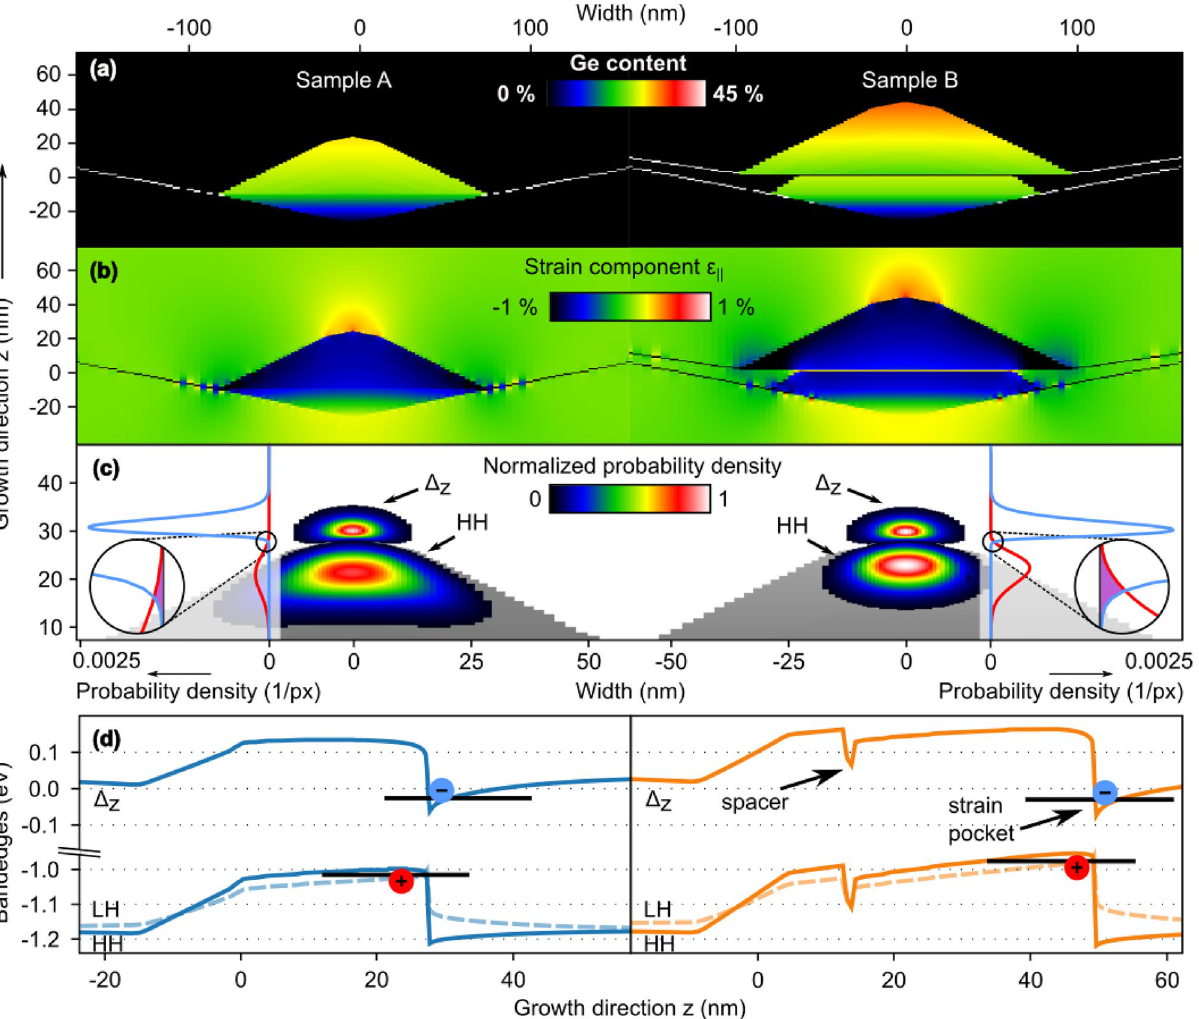
Figure 4. ( a – c ) Comparative nextnano++ simulations of a single Si 1 − x Ge x QD (left) and a vertically stacked double QDs separated by a 2nm thick Si spacer (right) in a Si matrix. ( a ) Cross-sectional view of the layer stacks with color-coded Ge-content x . ( b ) Corresponding in-plane strain component ε (cid:31) . The maximum tensile in-plane-strain in the Si matrix occurs above the Ge-rich apices of the QDs. ( c ) Normalized probability densities for heavy holes (HH) and (cid:31) z -electrons for the QD sequences in ( a ) as color-code and line-plots. The HHs are located in the single and in the upper QDs, respectively, the (cid:31) z -electrons above the respective apex. The color code is from black (vanishing probability) to white (maximum probability). The insets show the probability density per pixel, i.e., simulation node and an enhanced overlap for the double-dot structure which is highlighted by the inserted zoom-ins. ( d ) Schematic band edges for (cid:31) z -electrons, HH and LH of both samples. The black lines indicate the ground state energy levels of (cid:31) z -electrons and